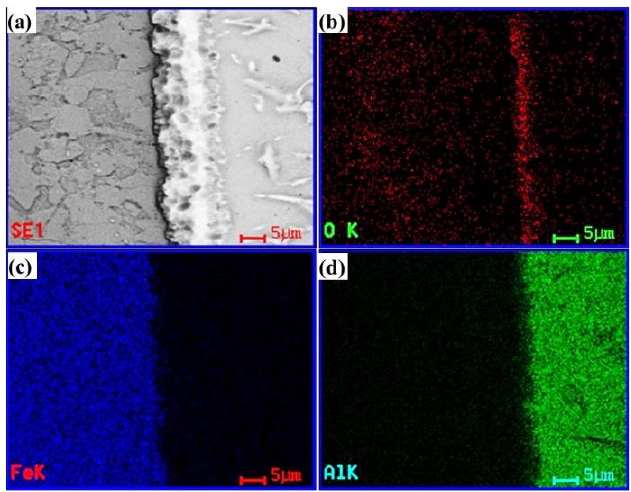
Figure 7. SEM image and EDS map elemental distributions of steel — Al alloy coating interface for steel with flux pre-treatment surface and dipping time for 30 s, ( a ) SEM image, ( b ) O map, ( c ) Fe map, ( d ) Al map.